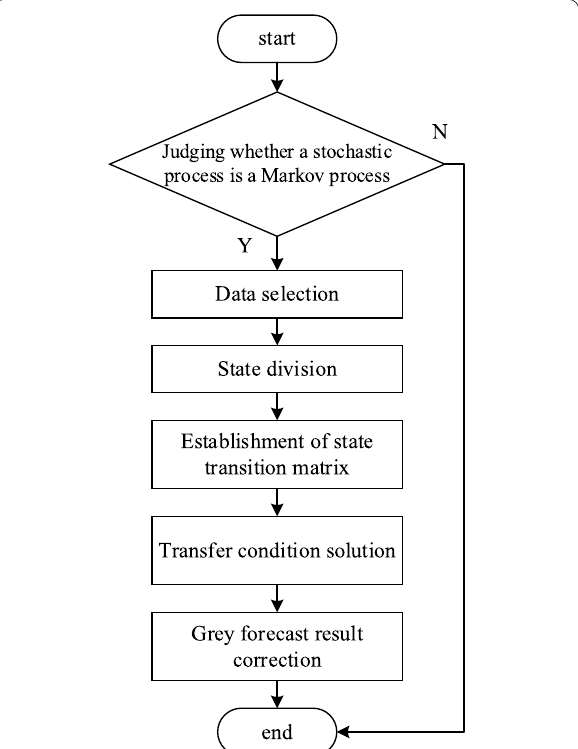
Figure 3 Prediction process of Markov